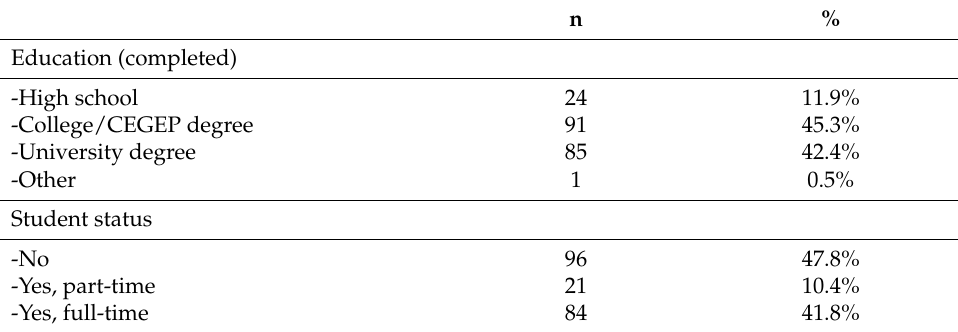
Table 1. Sociodemographic characteristics of the